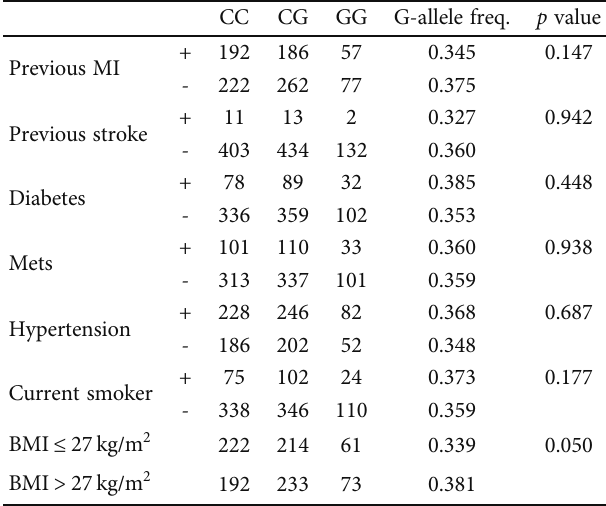
Table 3: Frequency of the NLRP3 variant according to comorbidity at